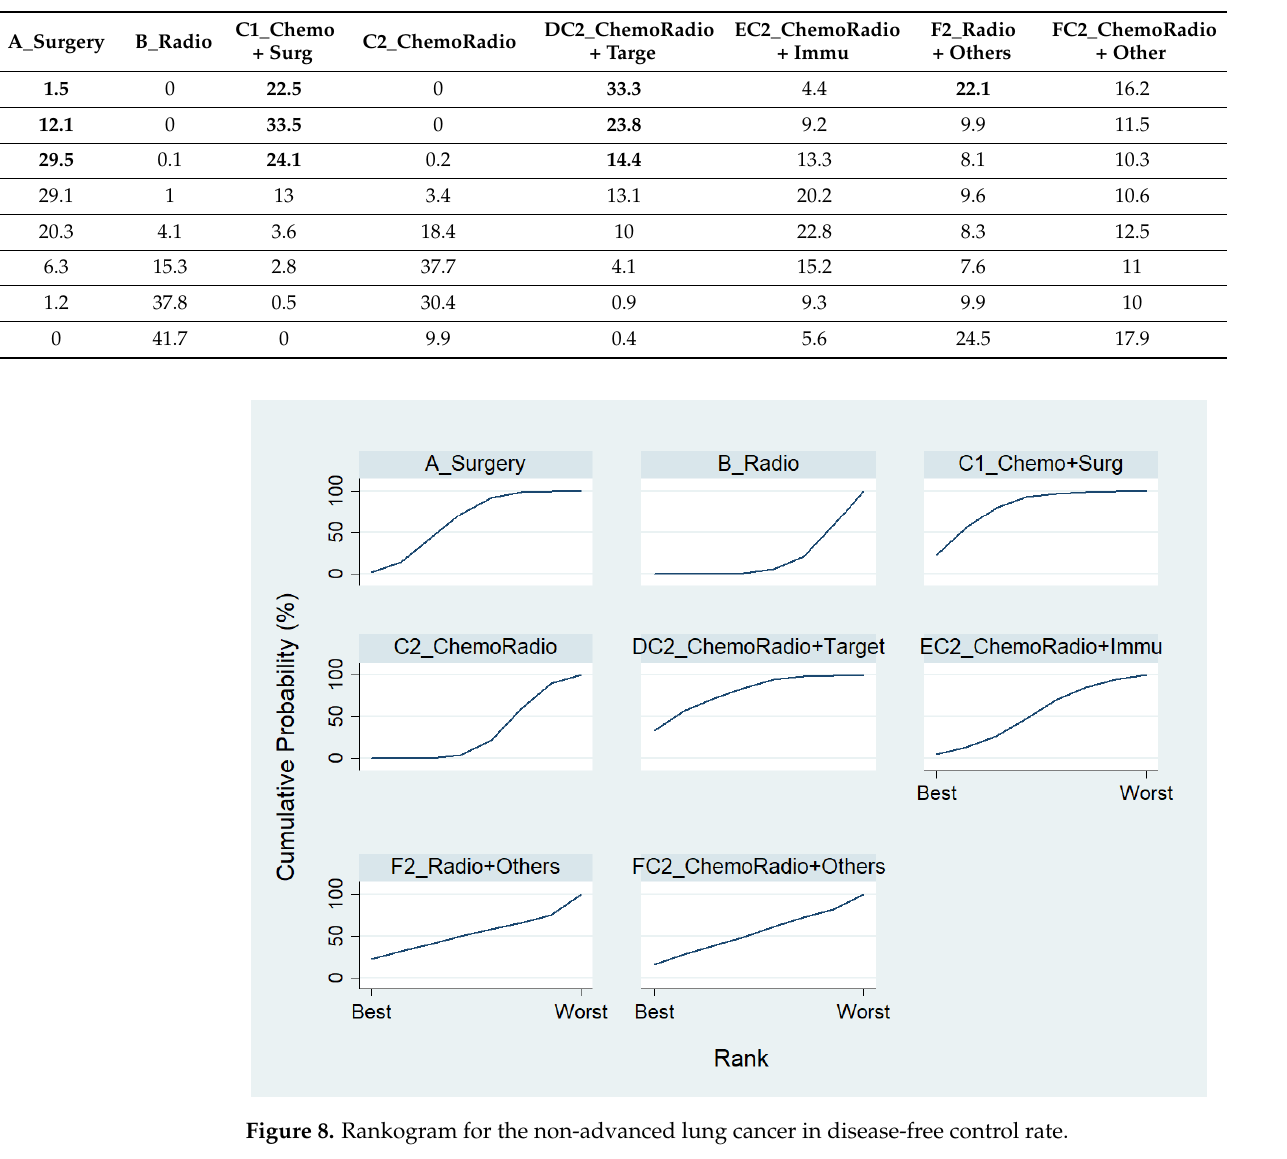
Table 6. Estimated cumulative probabilities (%) of each treatment being the best in disease-free control rate (Non-advanced stage, Component II).